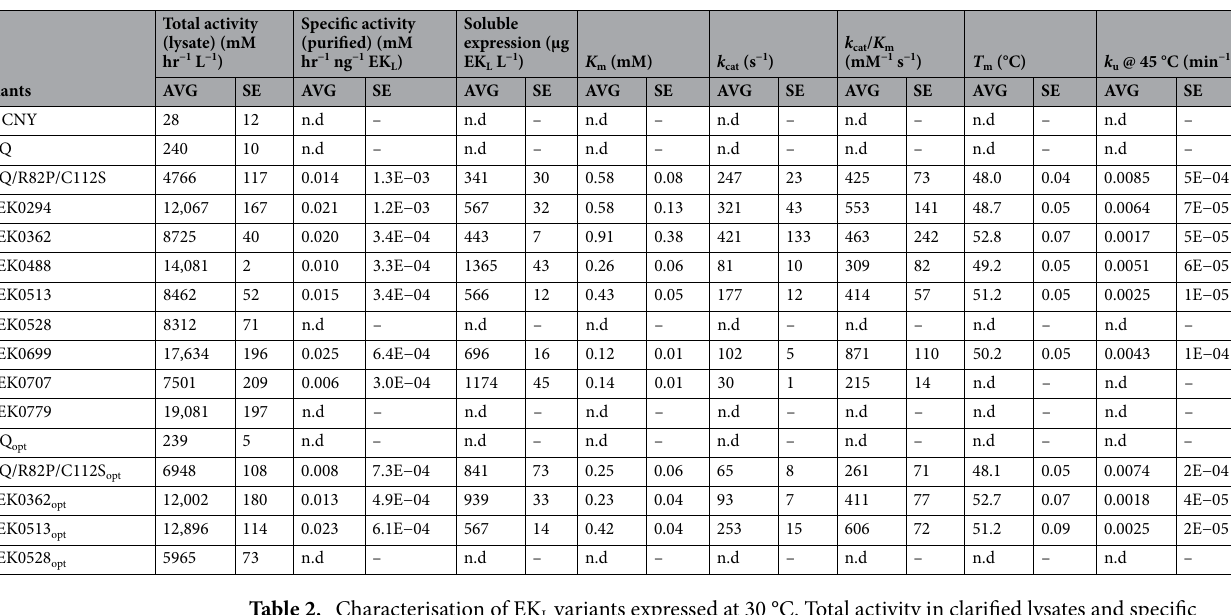
Table 2. Characterisation of EK L variants expressed at 30 °C. Total activity in clarified lysates and specific activity for purified enzyme were each assayed using 0.0625 mM substrate. Soluble expression = Total activity/ Specific activity. n.d.—no data.